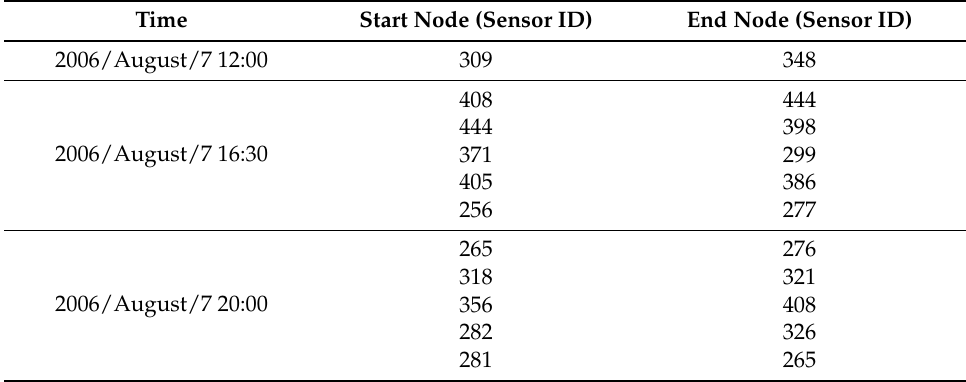
Figure 8. Route path and sensor status generated by our method compared with the path generated by the tracklet graph method in the same one minute. The solid line in the graph is the trajectory extracted by the tracklet graph model. The dashed line in the graph is the missing trajectories that have been extracted by our method but missing by the tracklet graph model. ( a ) Trajectory and sensor status extracted at 8:30; ( b ) Trajectory and sensor status extracted at 12:00; ( c ) Trajectory and sensor status extracted at 16:30; ( d ) Trajectory and sensor status extracted at 20:00. Table 2. Absent trajectories that are missing compared with the tracklet graph method.